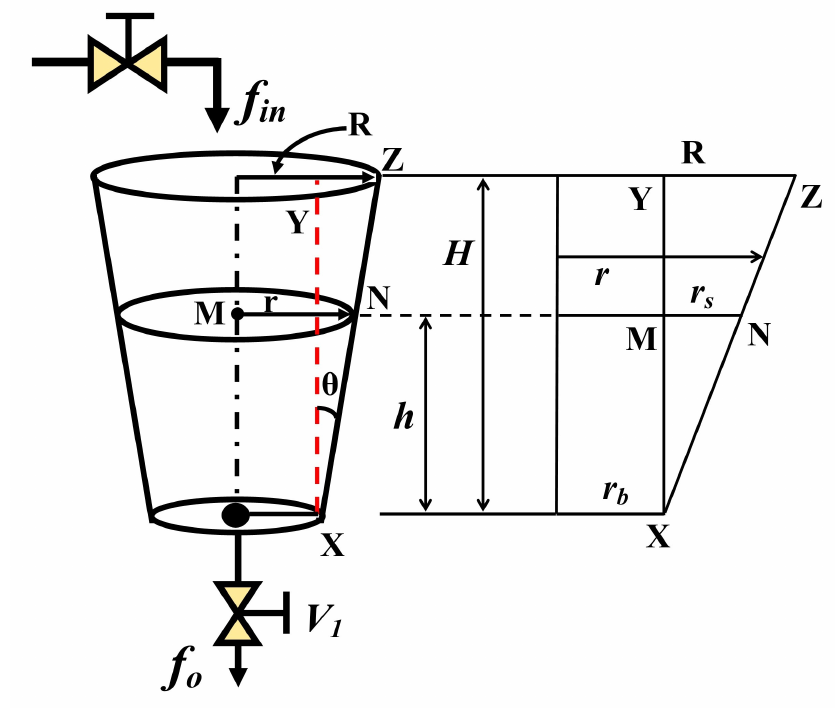
Figure 4. Variables of the frustum single tank for the non-linear model